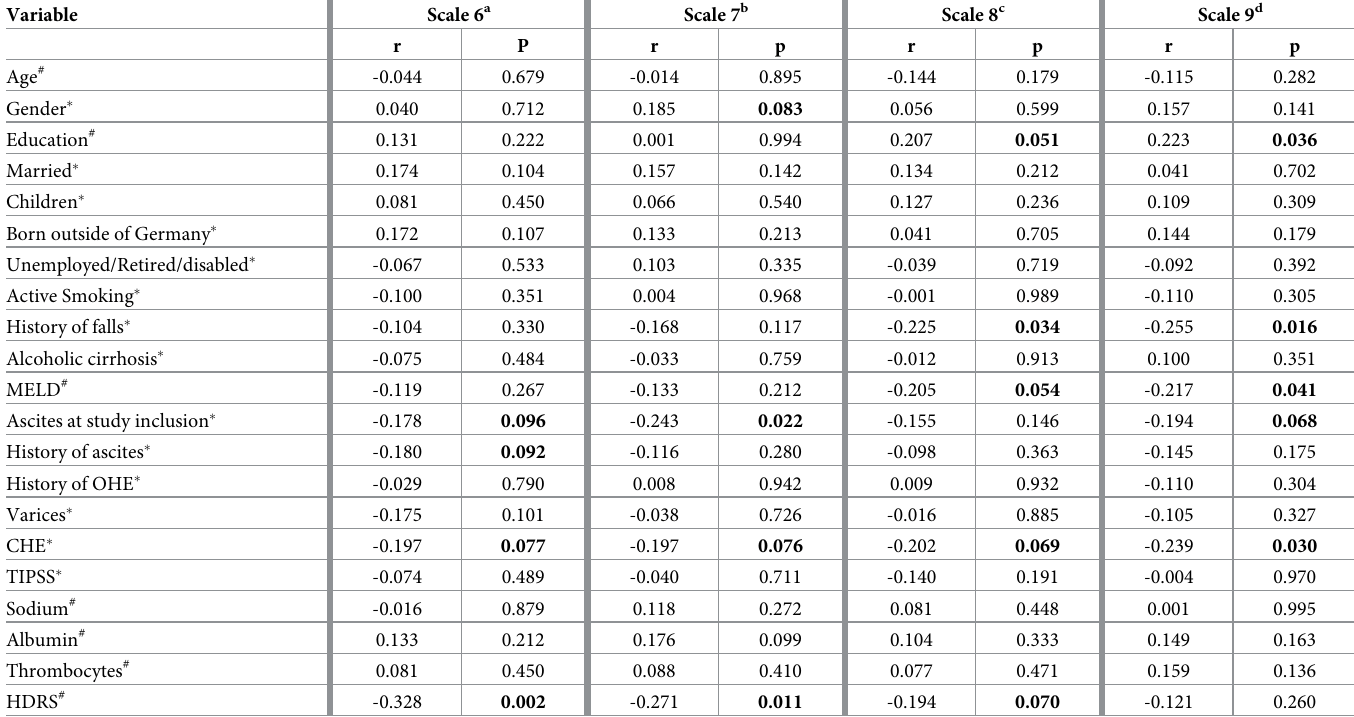
Table 3. Univariable analyses of risk factors of the HLQ subscales 6–9.